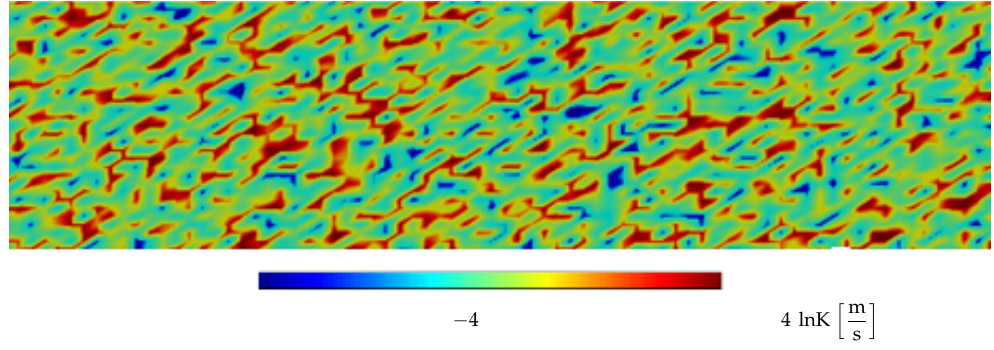
Figure 7. The hydraulic conductivity